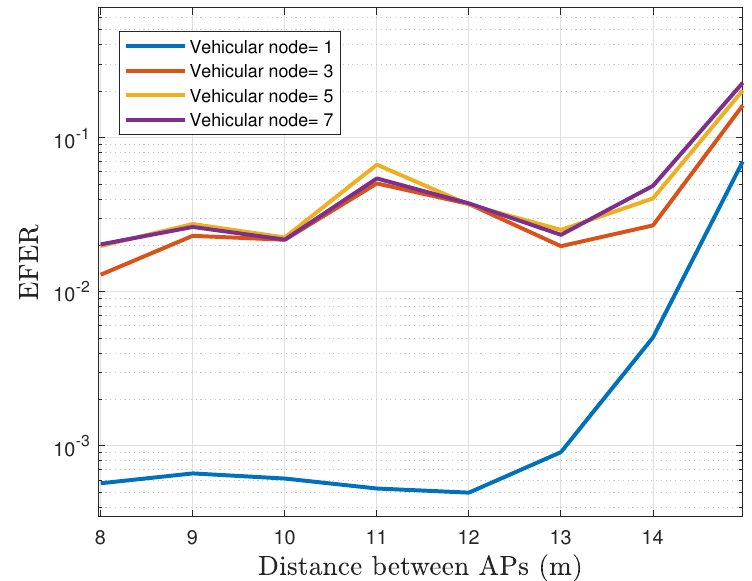
Figure 22. The EFER for different number of vehicular nodes operating in the network.